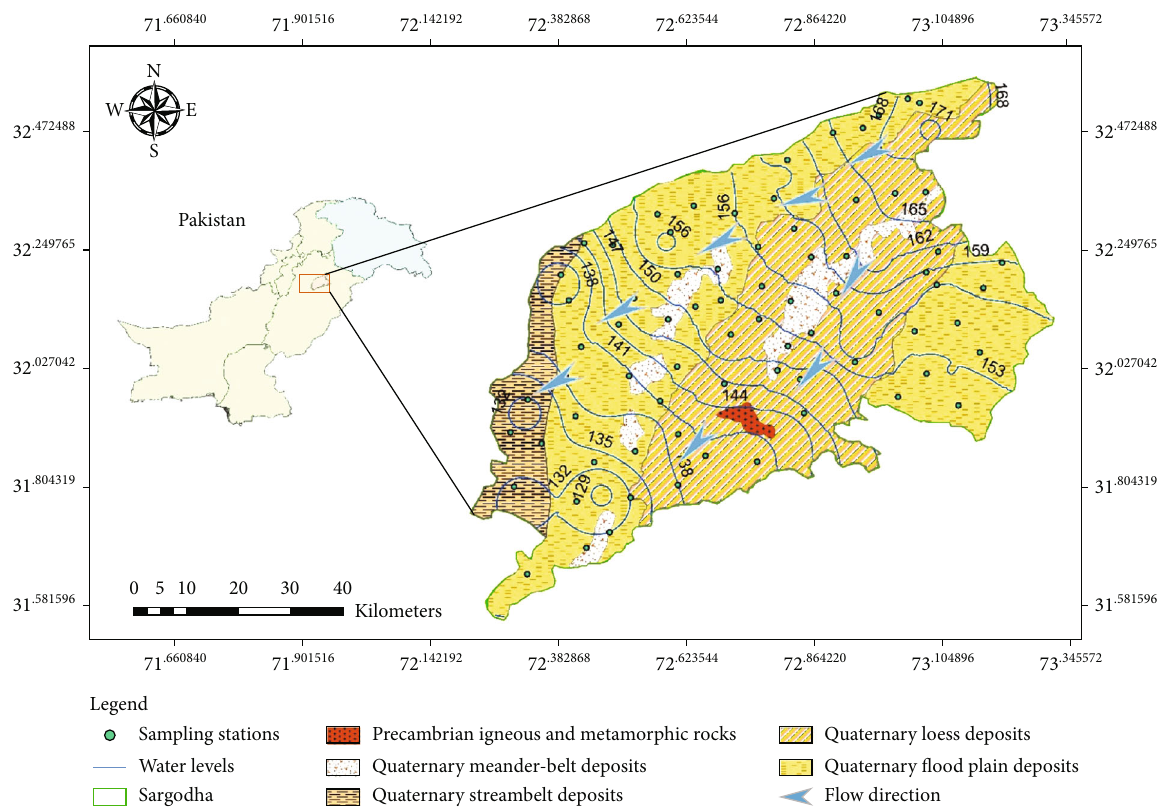
Figure 1: Location map of the study area and sampling